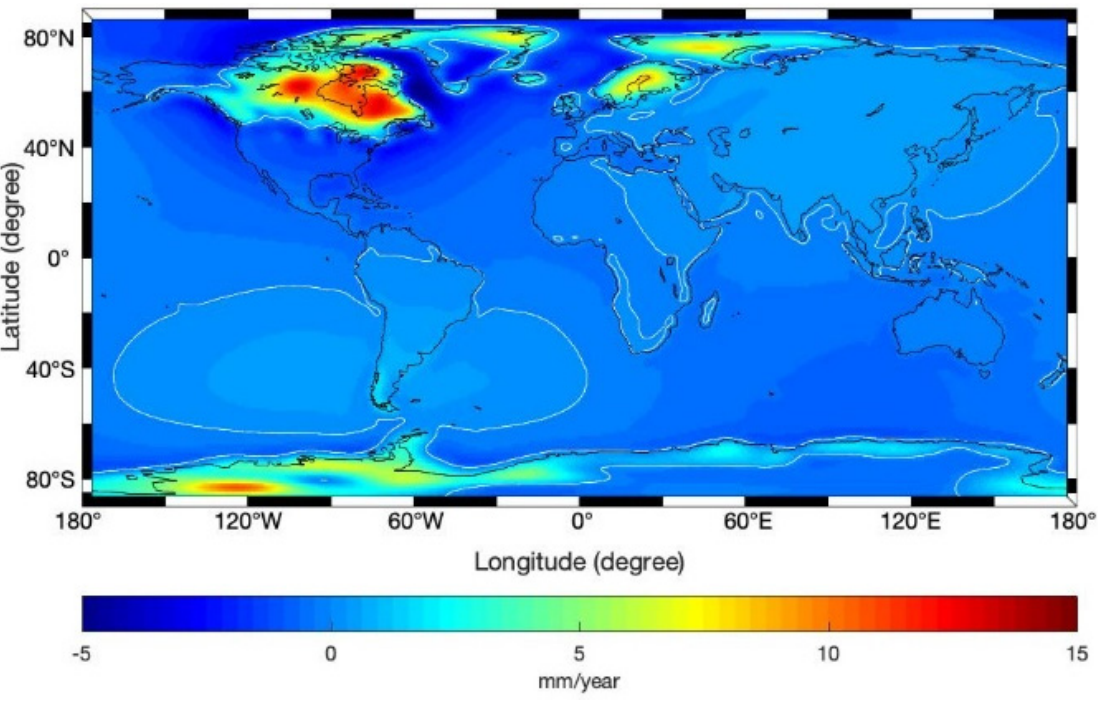
Figure 5. Uplift rates for the weighted average GIA model ICE6Gavg. The zero-motion contours are indicated by white curves.